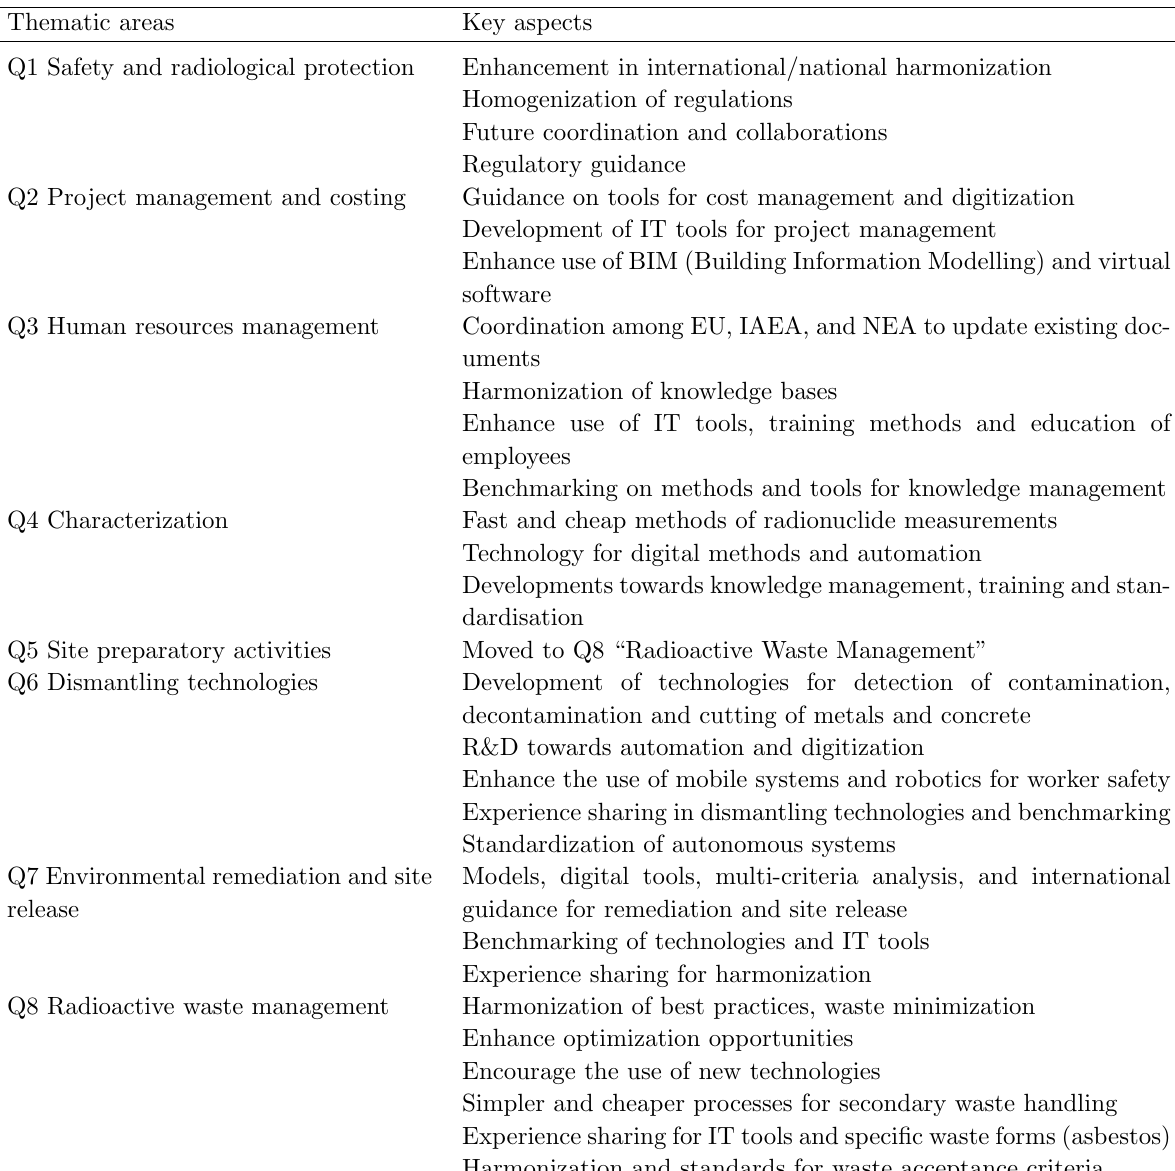
Table 2. Key aspects of the gap analysis by thematic